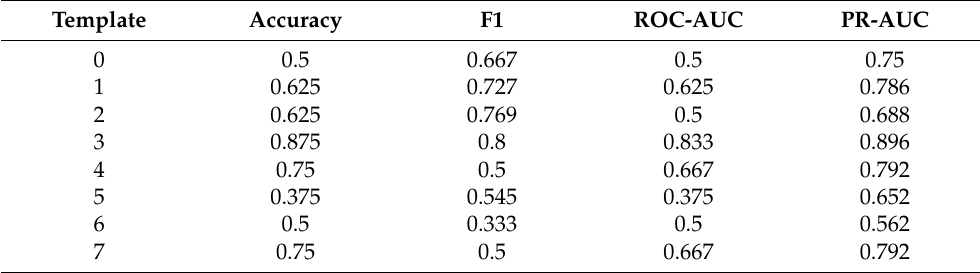
Table 3. Classification in eight test data of ensemble voltages on AF type through LOOCV.